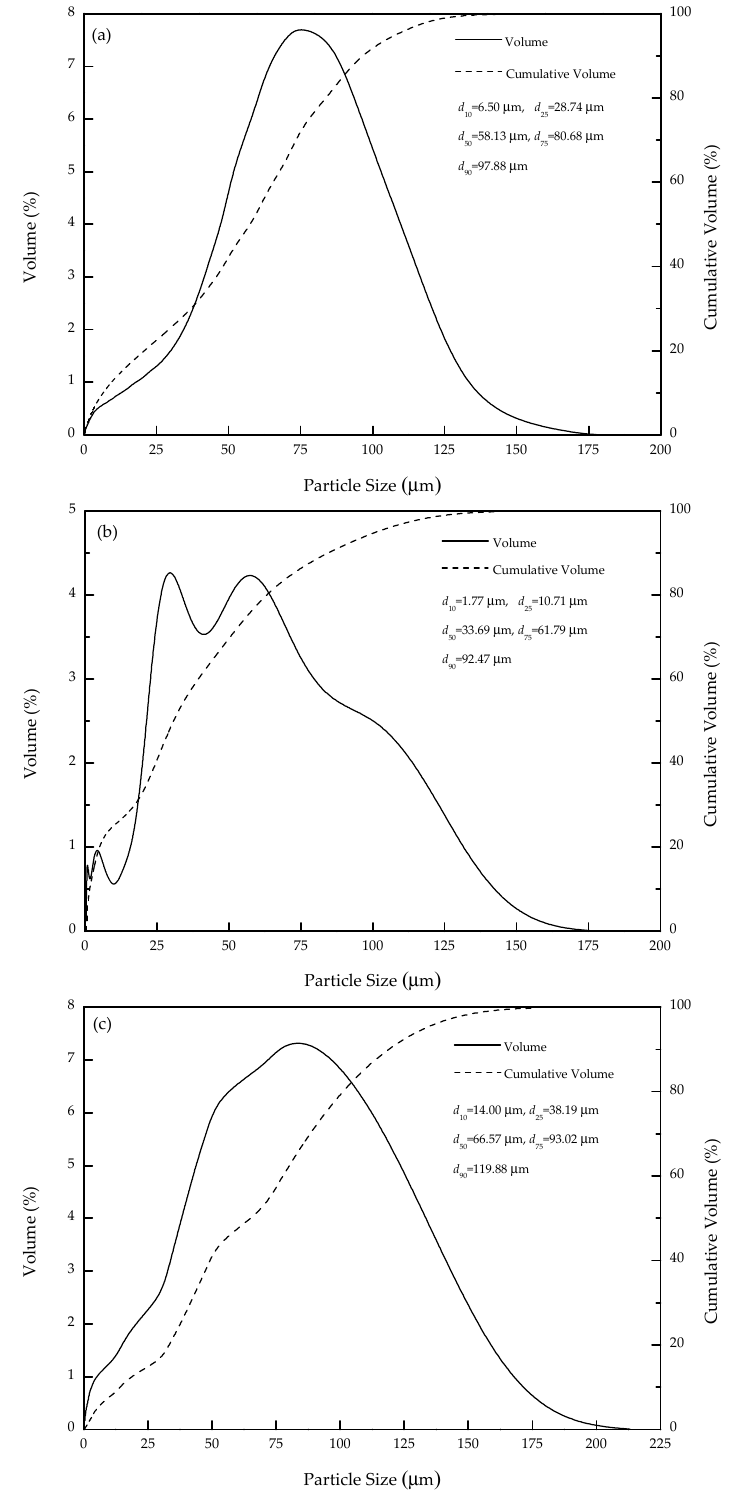
Figure 2. Particle size distribution of the synthetic perovskite ( a ), titanaugite ( b ), and MA-spinel ( c ).